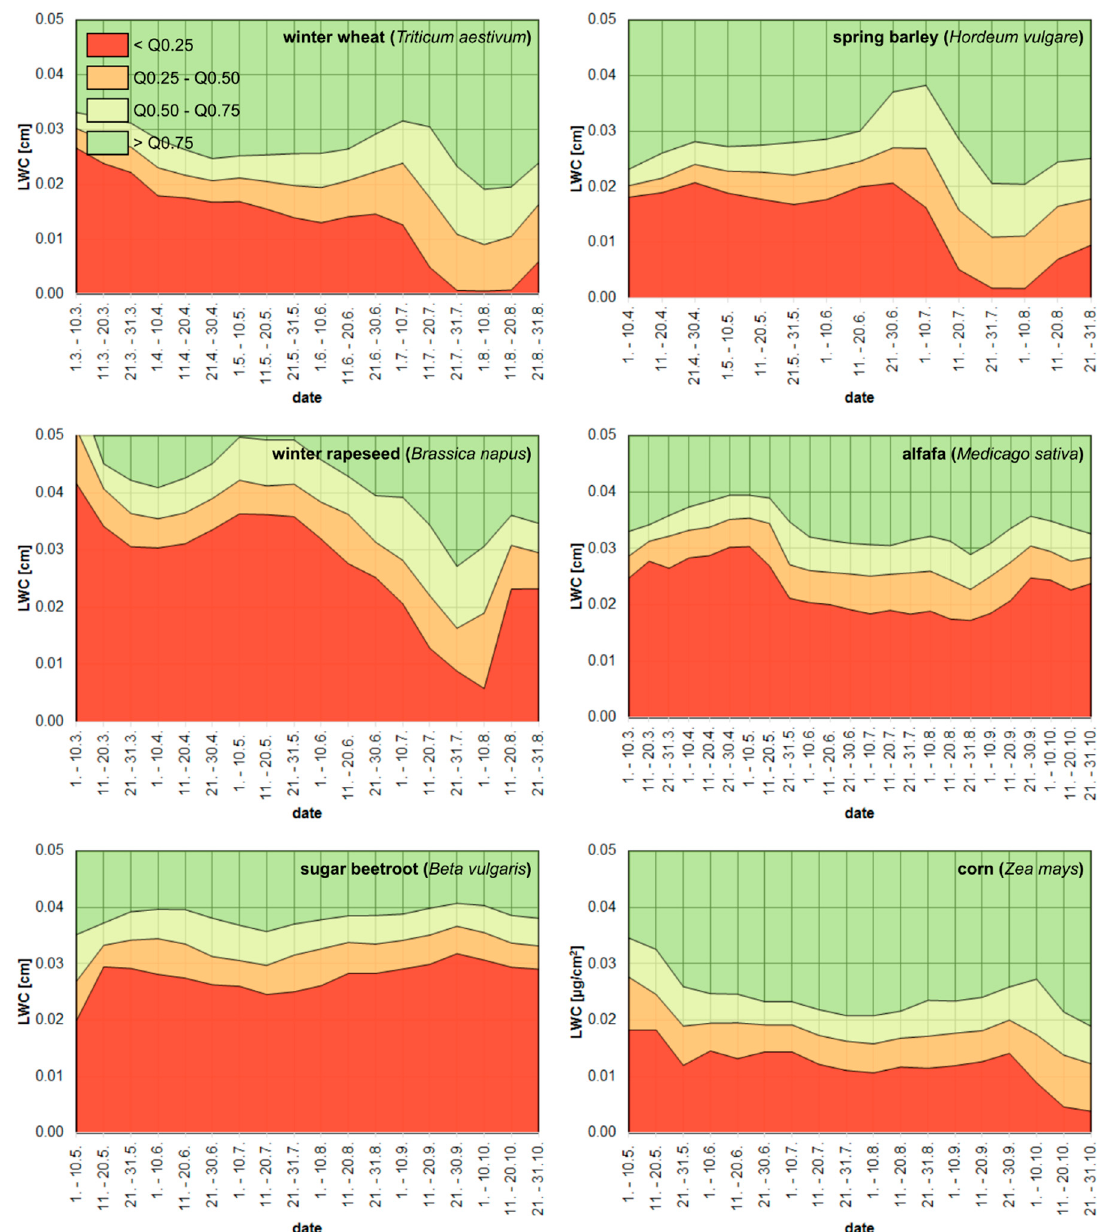
Figure A6. Temporal changes in estimated leaf water content (LWC) values for all six crops of interest demonstrated using Q0.25, Q0.50, and Q0.75 quantiles.